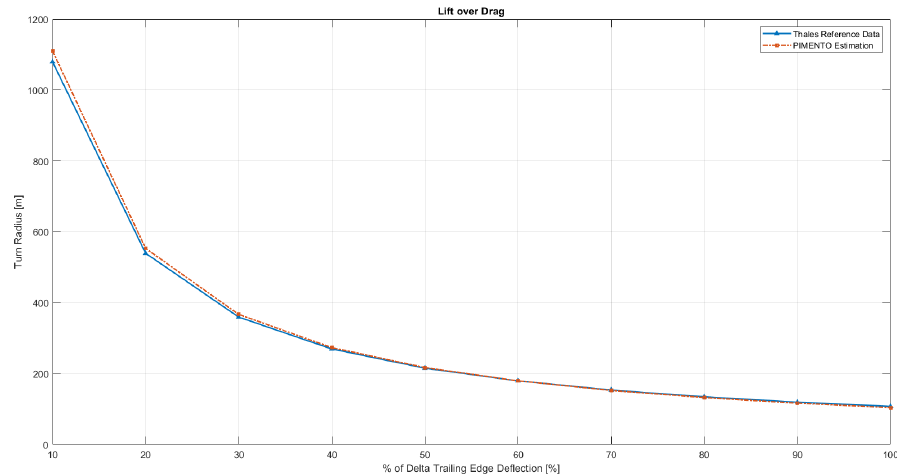
Figure 4. Turn radius over different asymmetric deflections of the parafoil trailing edge. The reference data of TAS − I are in blue. The PIMENTO data are in